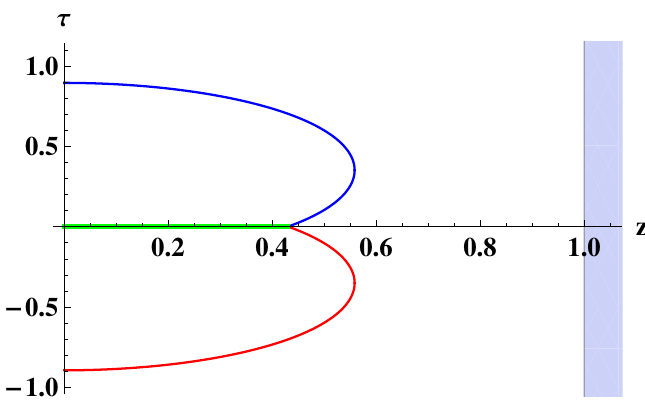
Figure 2 . A symmetric configuration for ∆ 1 = ∆ 2 = 30 and ∆ 3 = 40 , with the operator O 3 placed in the middle point between O 1 and O 2 . Geodesics 1, 2 are returning and geodesic 3 is ingoing. In this symmetric case, the latter is a straight line between z = 0 and z I . [Red, blue and green colors represent the geodesics representing operators O 1 , O 2 and O 3 ,